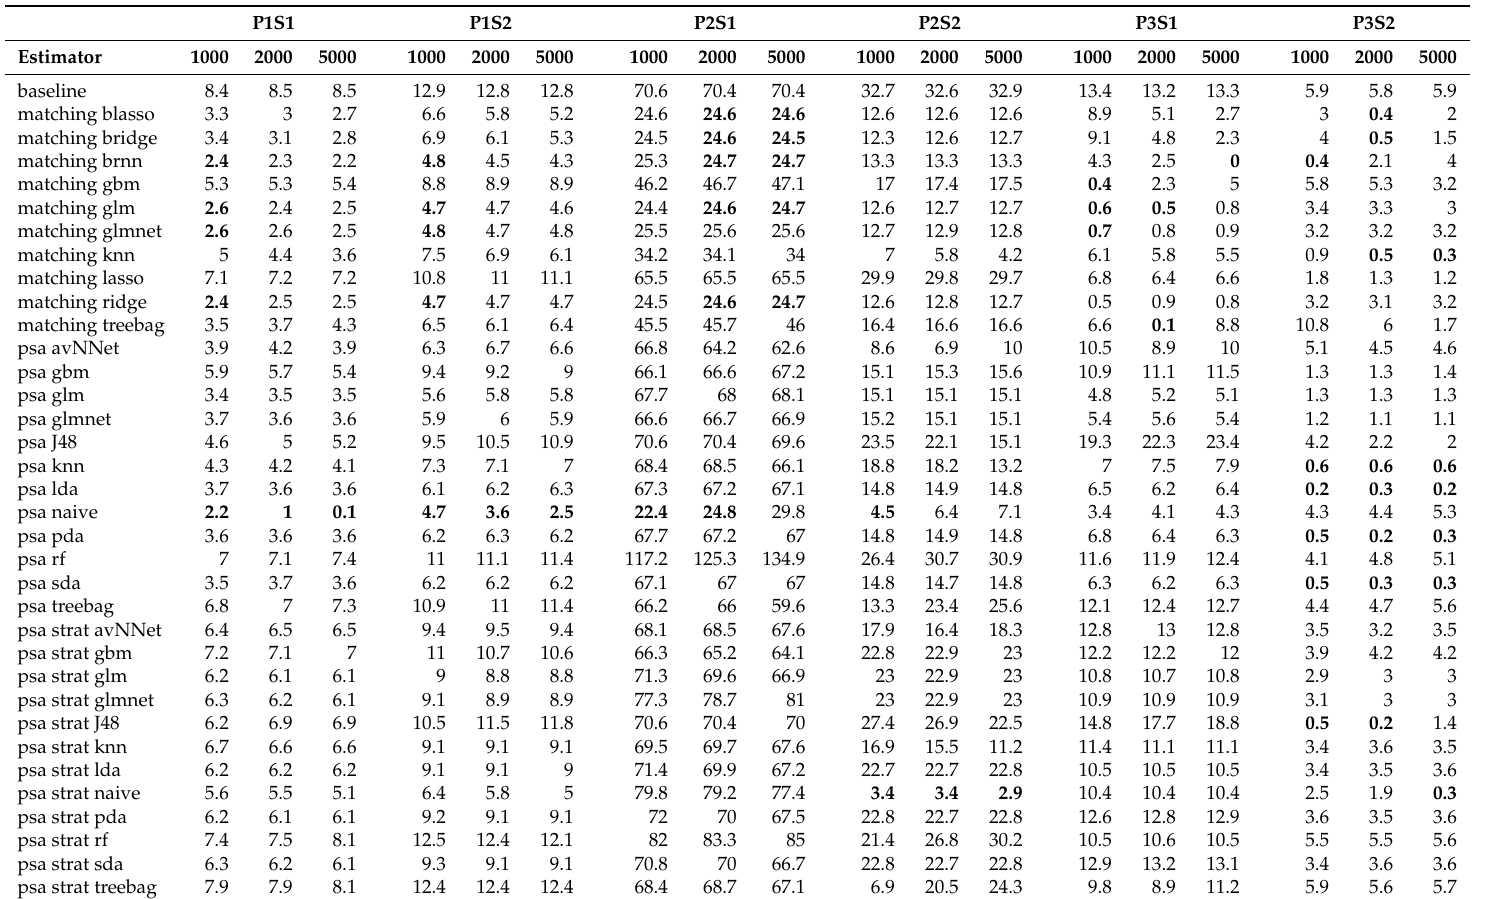
Table A1. Relative mean bias (%) of each estimator for each population, sampling method, and sample size. The best values among the methods are shown in